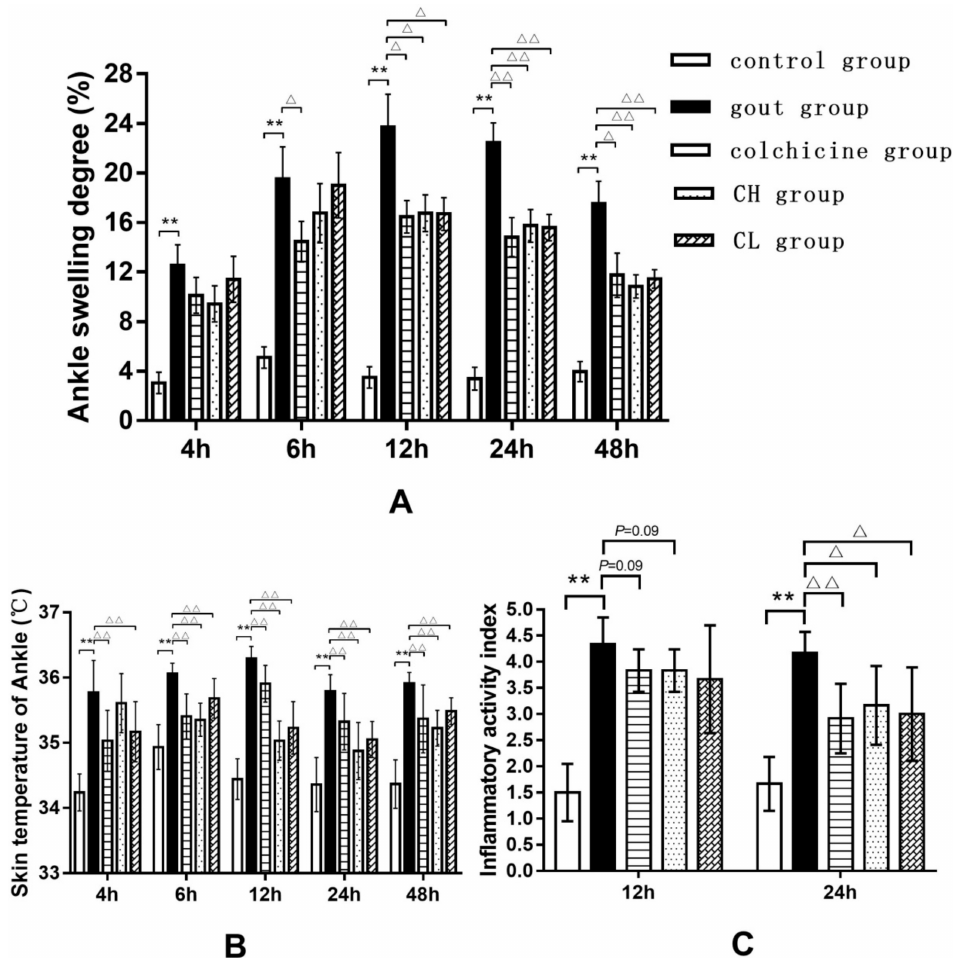
Figure 1. E ff ect of chicory on ankle edema and inflammatory activity index in MSU-induced gout rats: ( A ) Ankle swelling degree, ( B ) skin temperature of ankle, and ( C ) inflammatory activity index. Data are expressed as mean ± SD for 10 rats in each group. ** p < 0.01 vs. control group. (cid:52) p < 0.05, (cid:52)(cid:52) p < 0.01 vs. gout group. Abbreviations: CH, high-dosage chicory treated group; CL, low-dosage chicory treated